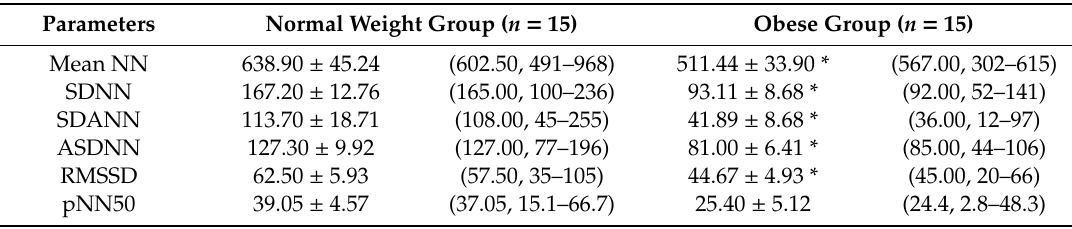
Table 7. Time domain of heart rate variability in normal weight and obese groups. Mean ± SE (median, minimum-maximum) are